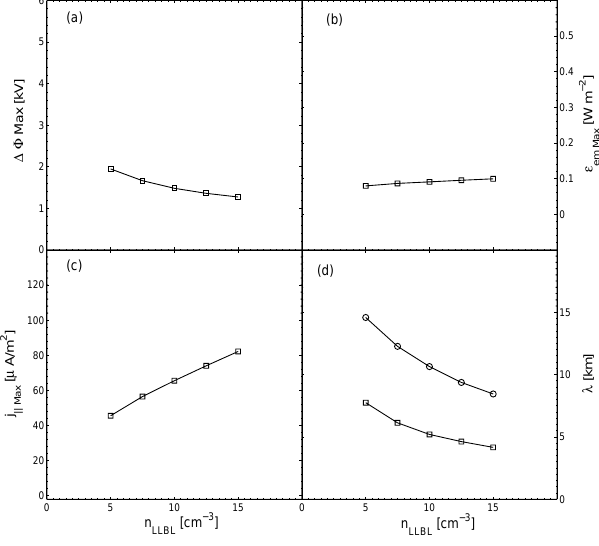
Fig. 7. Variation of arc characteristics as a function of the density at the LLBL side of the TD; same panel description as in the caption of Fig.